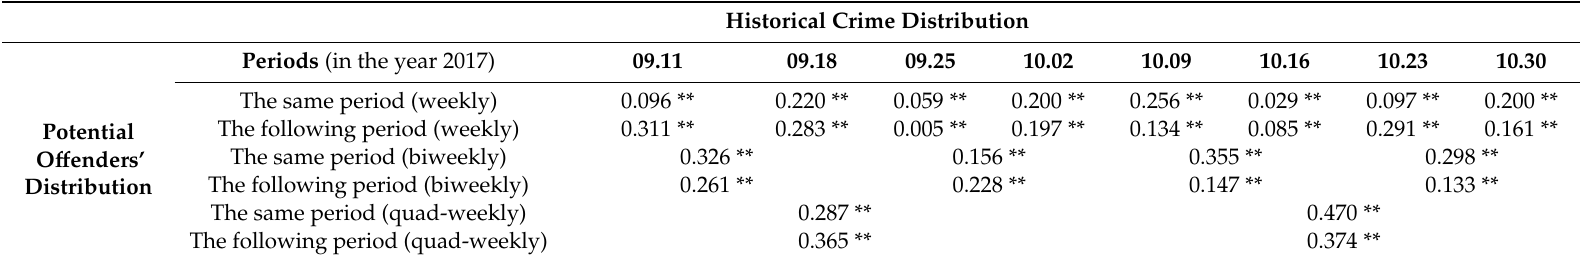
Table 1. The Spearman Rank Correlation between historical crime distribution and potential o ff enders’